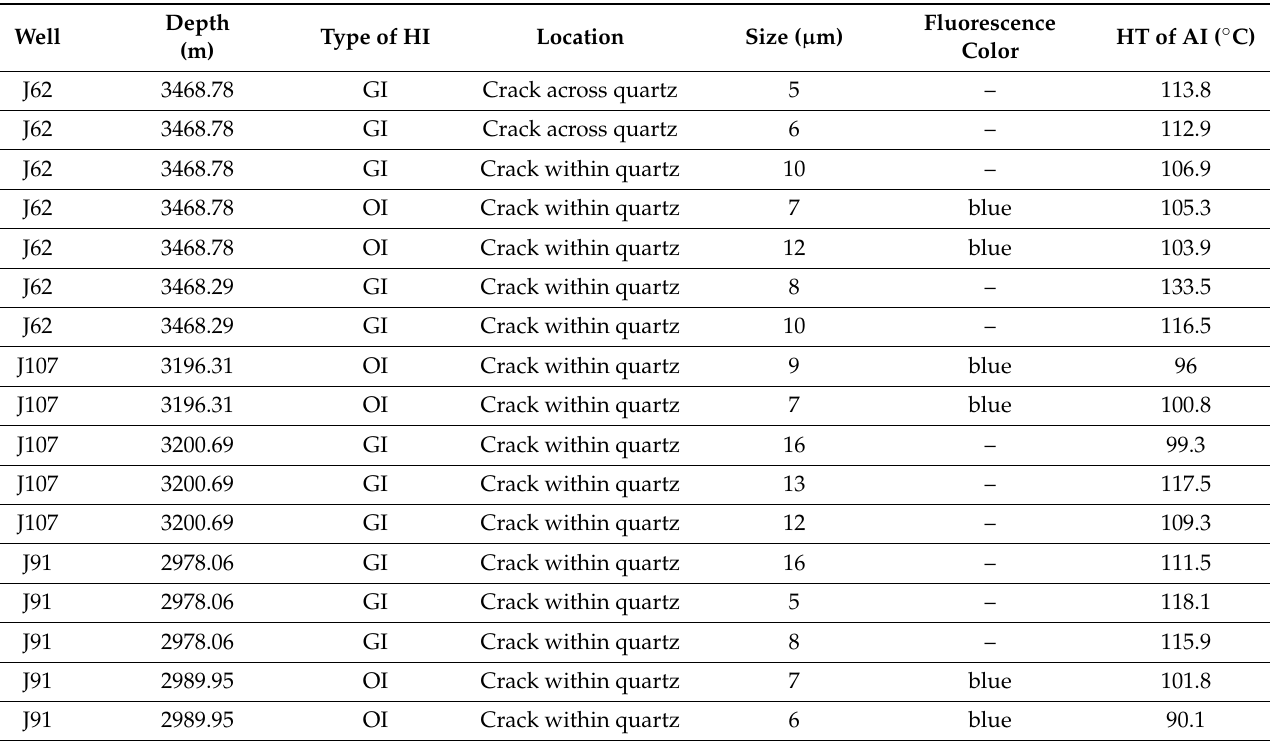
Figure 8. The current pressures and pressure coefficients of the Upper Paleozoic sandstones in the Hangjinqi area.